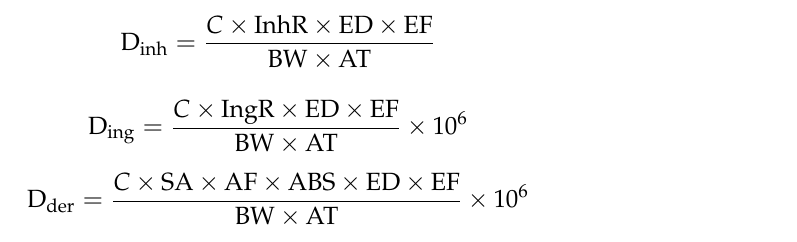
Table 1. Exposure factors for health risk assessment model.